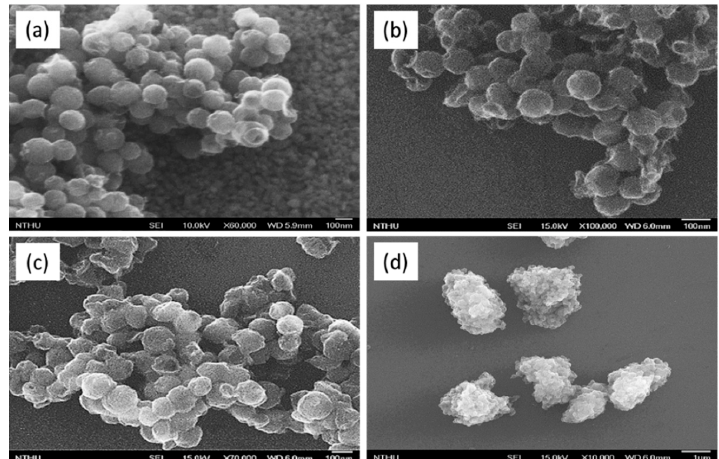
Figure 2. SEM images. ( a ) Hollow mesoporous carbon nanospheres (HMC). ( b ) O-HMC modified at 80 °C and 15 h. ( c ) O-HMC modified at 110 °C and 24 h. ( d ) O-HMC modified at 110 °C and 24 h on a small scale.